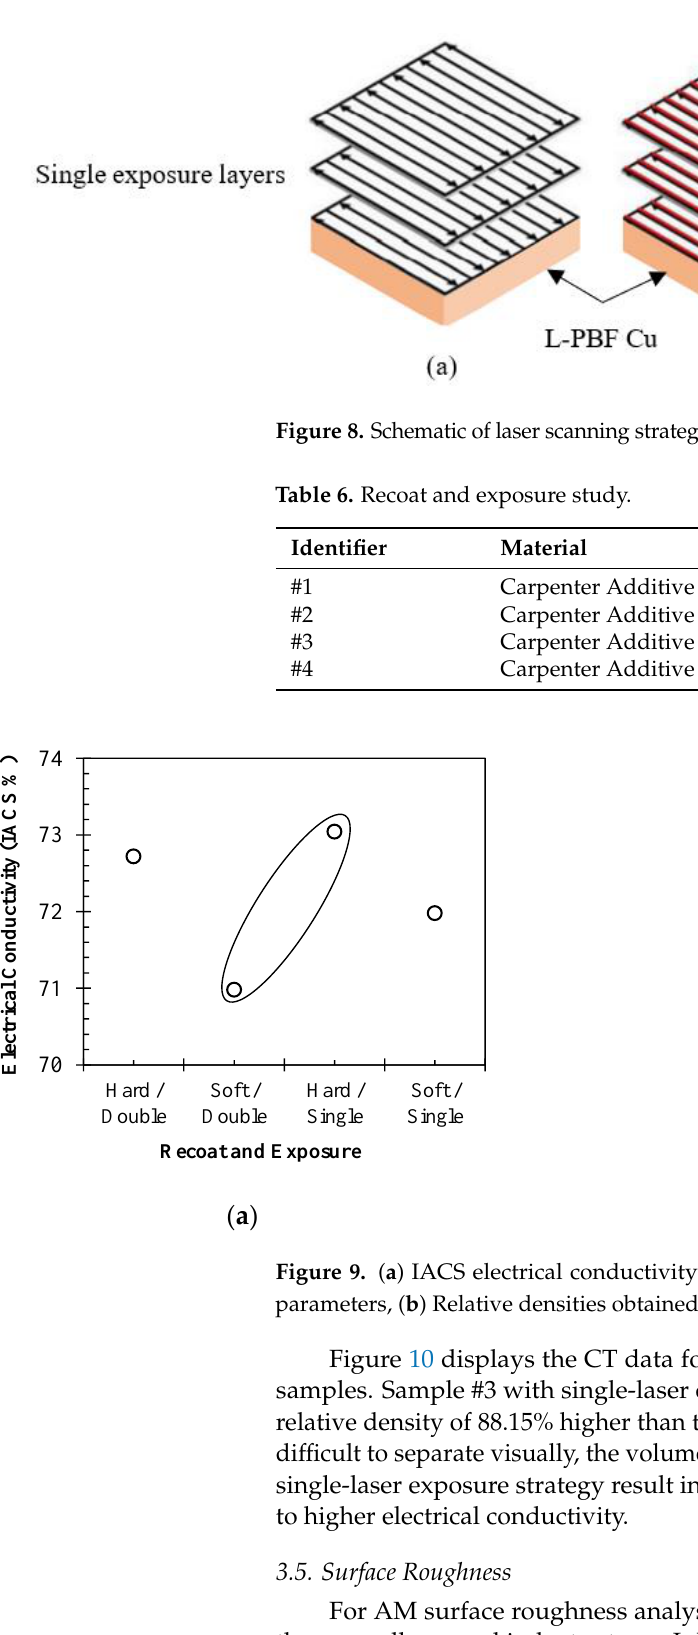
Figure 9. ( a ) IACS electrical conductivity performance for powder recoating and laser exposure pa- rameters, ( b ) Relative densities obtained for powder recoating and laser exposure parameters.